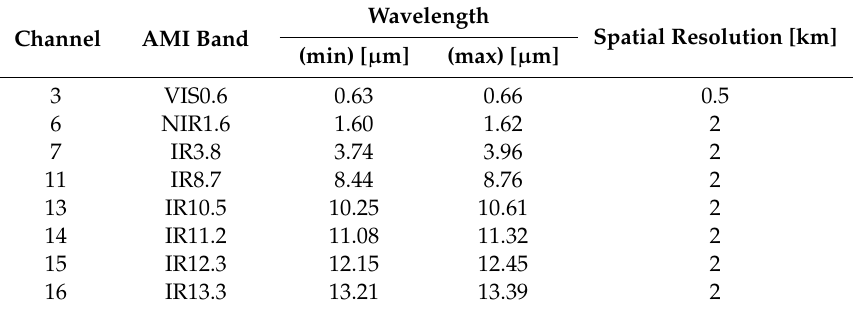
Table 1. Characteristics of the selected channels among the 16 channels of advanced meteorological imager (AMI) of GK2A used in this study. Wavelength Spatial Resolution [km] Channel AMI Band (min) [ µ m] (max) [ µ m] 3 VIS0.6 0.63 0.66 0.5 6 NIR1.6 1.60 1.62 2 7 IR3.8 3.74 3.96 2 11 IR8.7 8.44 8.76 2 IR10.5 10.25 10.61 2 14 IR11.2 11.08 11.32 2 15 IR12.3 12.15 12.45 2 16 IR13.3 13.21 13.39